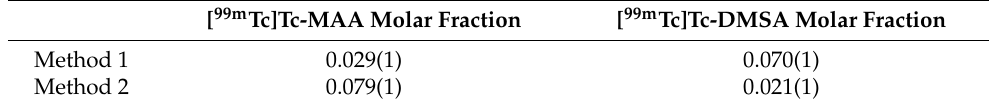
Table 7. Amount of 99m Tc atoms bound to MAA or to DMSA reported as molar fraction (Mean